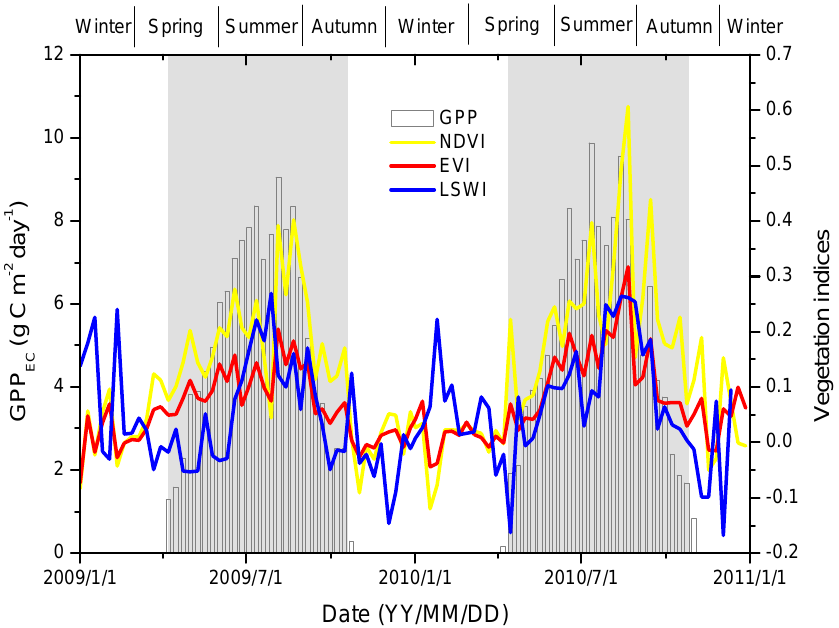
Figure 4. Seasonal dynamics of ( a ) Normalized Difference Vegetation Index (NDVI); ( b ) Enhanced Vegetation Index (EVI); ( c ) Land Surface Water Index (LSWI); and ( d ) estimated gross primary production from EC tower measurements (GPP EC ). Three vegetation indices come from MODIS imagery during 2009–2010 in the targeted wetland.